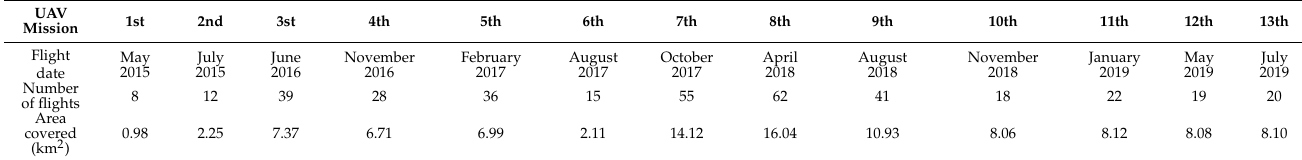
Table 3. Overview of all performed UAV missions for the study